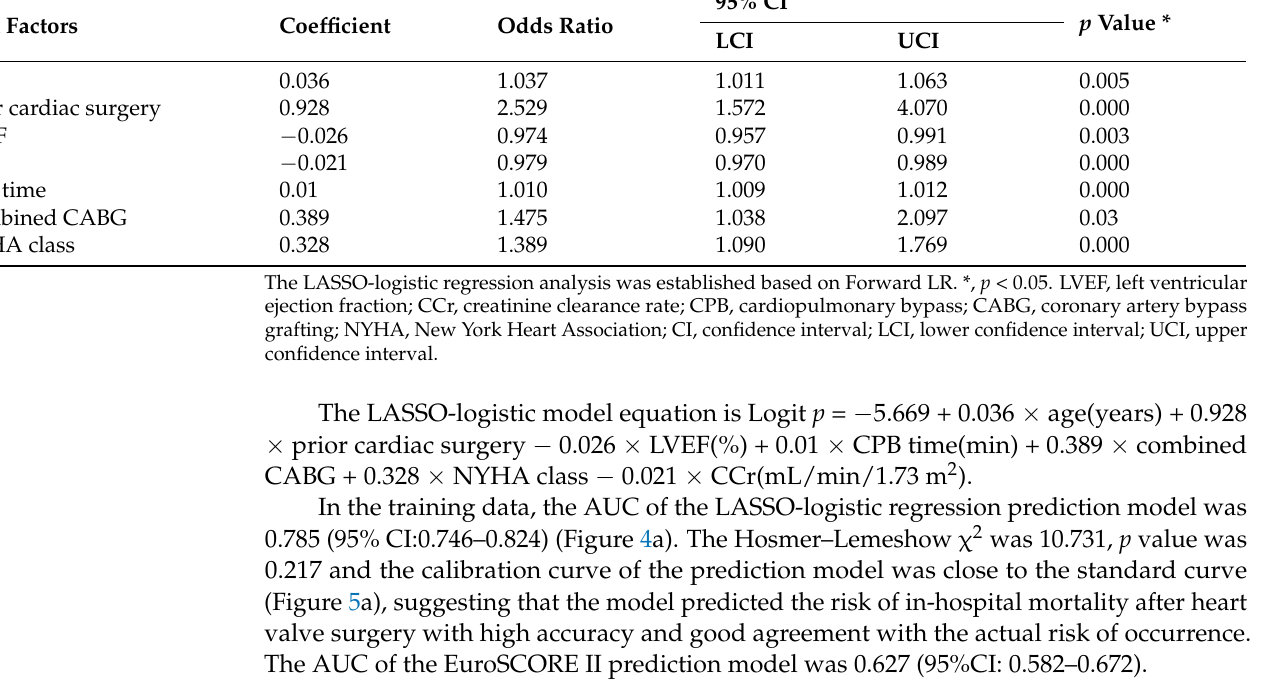
Table 3. Multivariable LASSO ‐ logistic regression analysis of perioperative parameters.